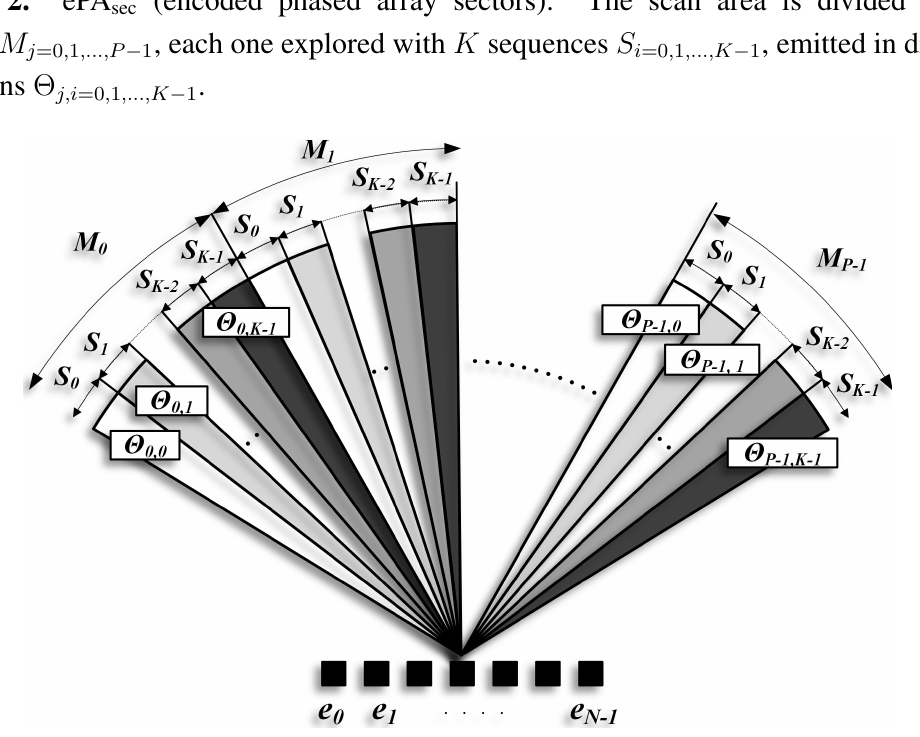
, emitted in different i =0 , 1 ,...,K − 1